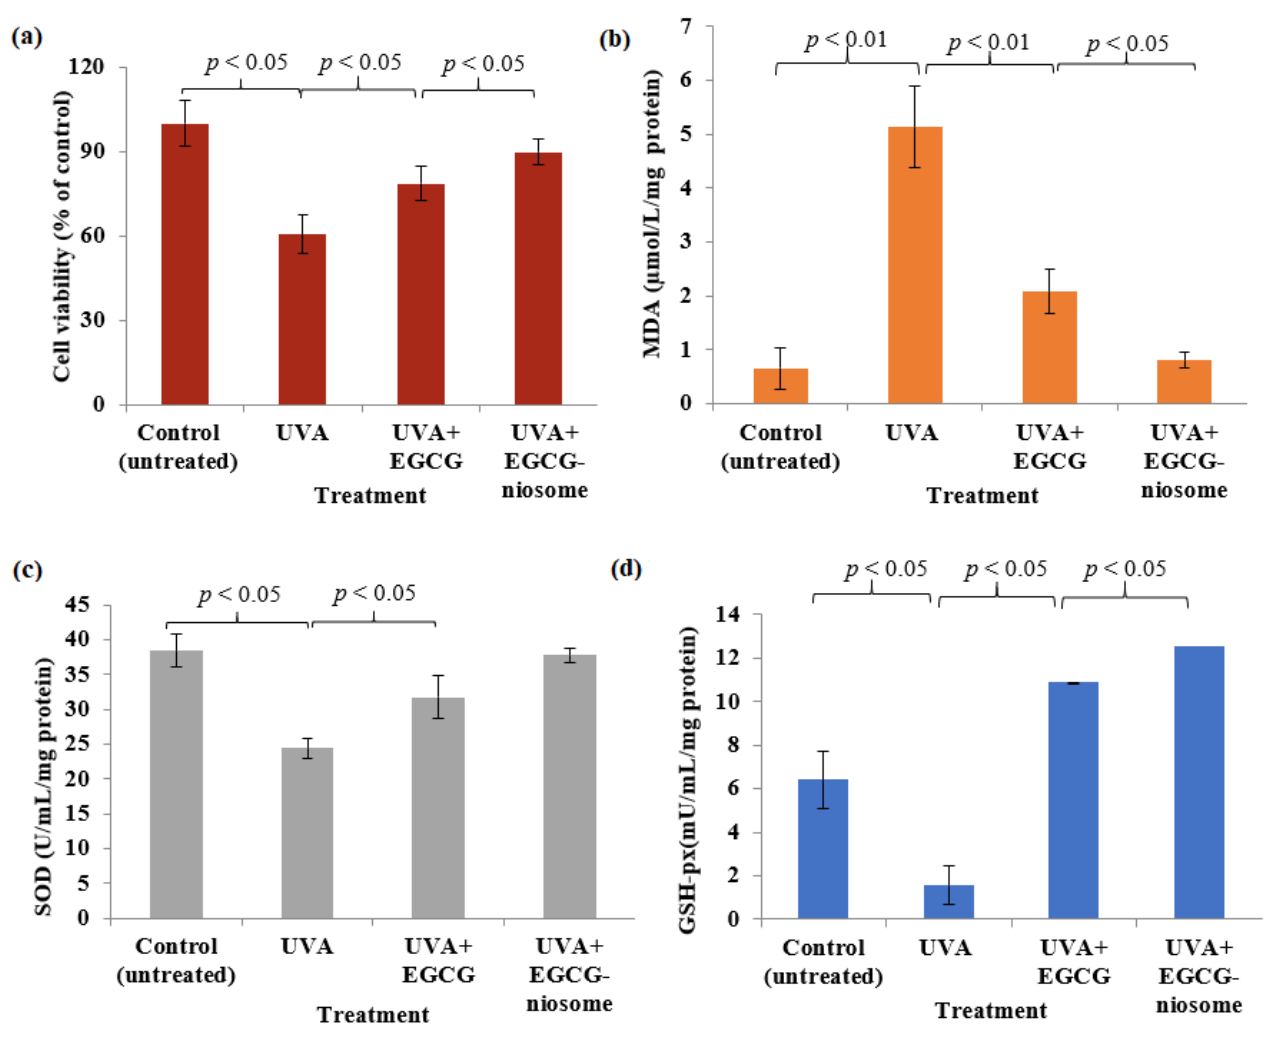
Figure 7. ( a ) Cellular viability after UVA-irradiation and treatment with EGCG and EGCG-niosomes. The effect of EGCG and EGCG niosomes on ( b ) intracellular malondialdehyde (MDA) level ( b ), ( c ) superoxide dismutase (SOD) and ( d ) glutathione peroxidase (GSH)-px after UVA-irradiation (mean ± SD, n = 3).